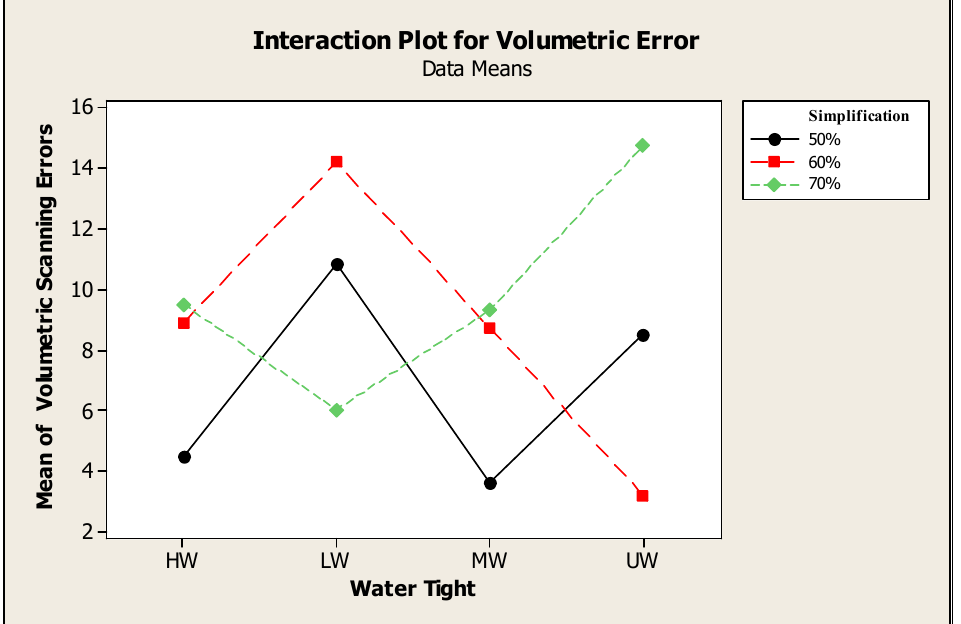
Figure 5. Main effects plot for volumetric error (Mode A).